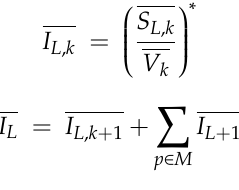
Figure 6. Single line diagram of RDN.